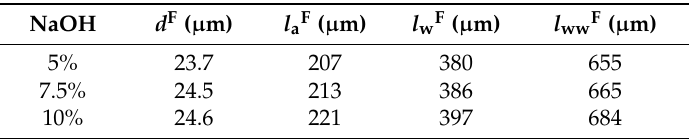
Table 3. Morphologic properties of the fibers extracted from the composites.